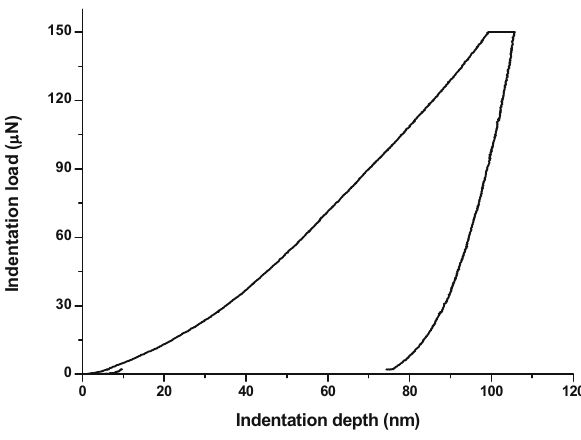
Figure 3: Typical loading – unloading curve of nanoindentation test.